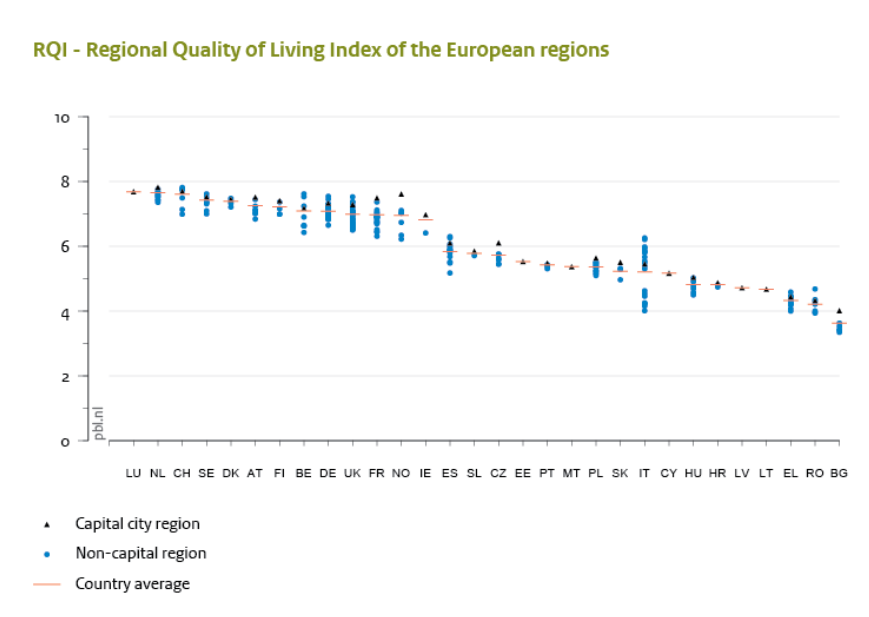
Figure 4: RQI values for the European NUTS2 regions, showing the average RQI value per country and its capital